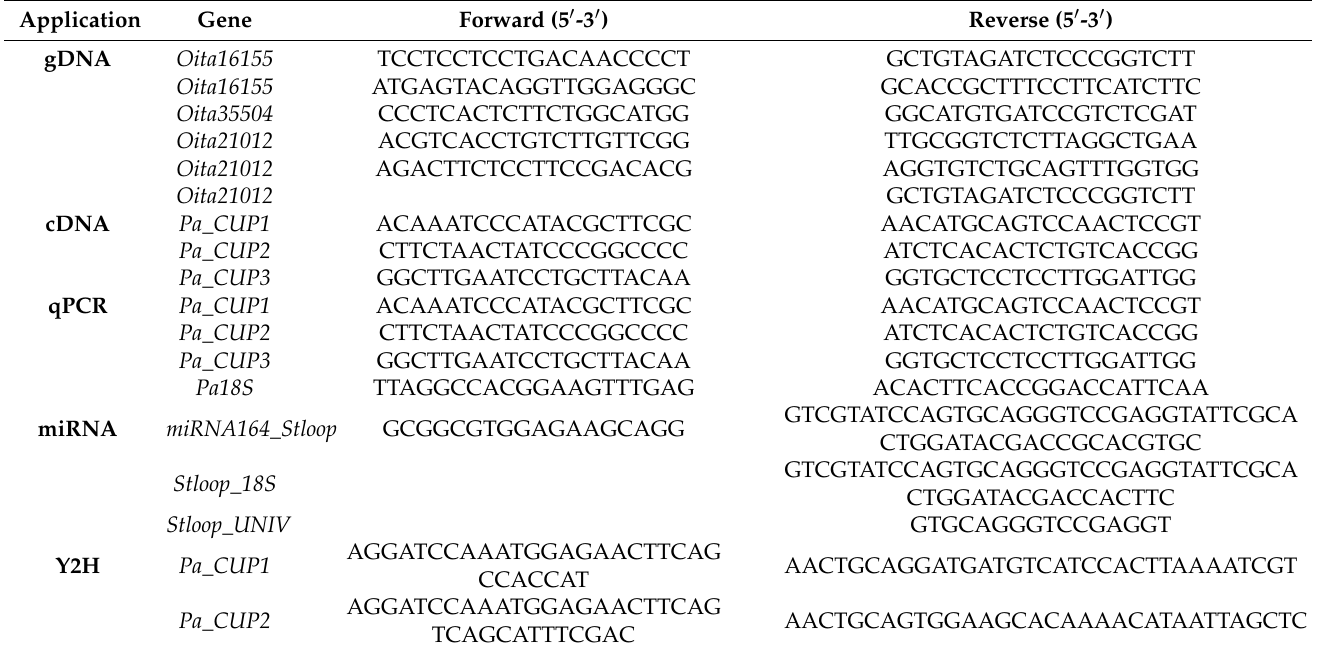
Table 1. List of the primer sequences used for genomic (gDNA) and cDNA sequence isolation, qPCR analysis, miRNA and Yeast two-hybrid